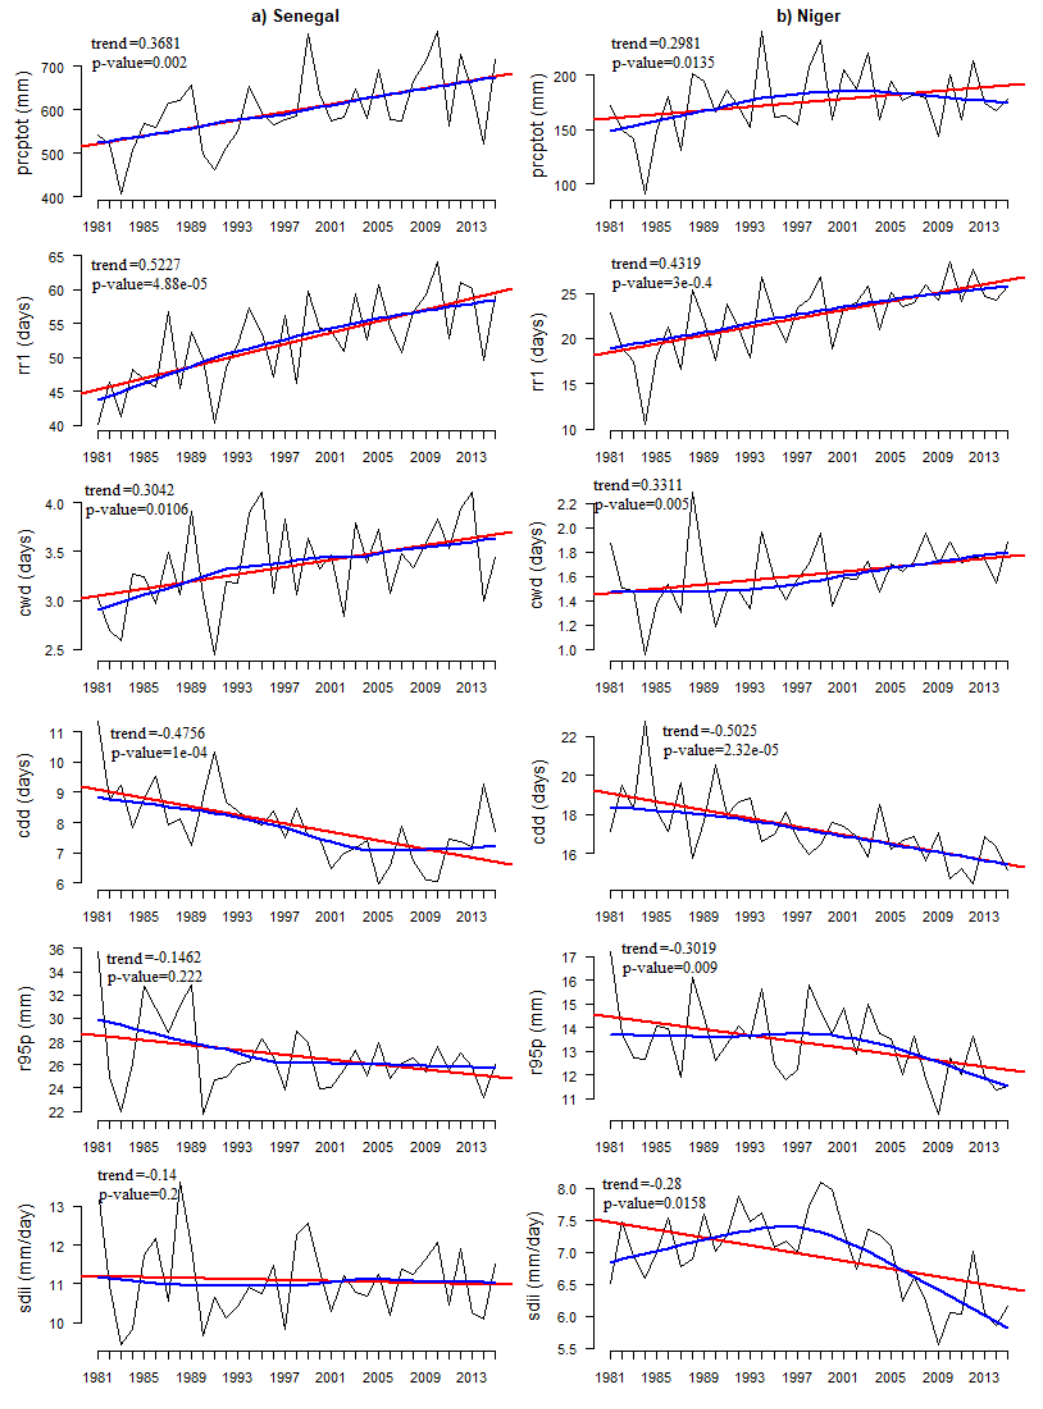
Figure 4. Time evolution of PRCPTOT (mm), RR1 (days), CWD (days), CDD (days), R95P (mm), and SDII (mm/day), averaged over ( a ) Senegal and ( b ) Niger. The red line corresponds to the linear regression in the time series (1981–2015) and the blue curve corresponds to the best fit of the weighted least squares, shown as the best line with the minimal distance from the data.